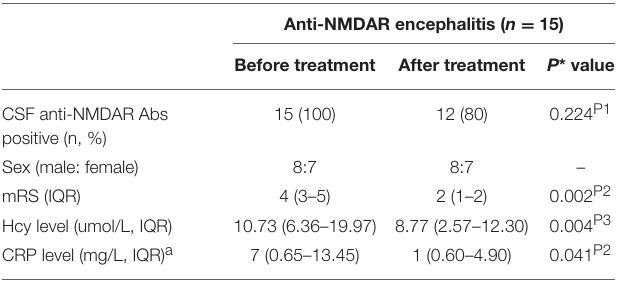
TABLE 4 | Demographics of the 15 anti-NMDAR encephalitis with 3-month follow-up. Anti-NMDAR encephalitis ( n = 15)